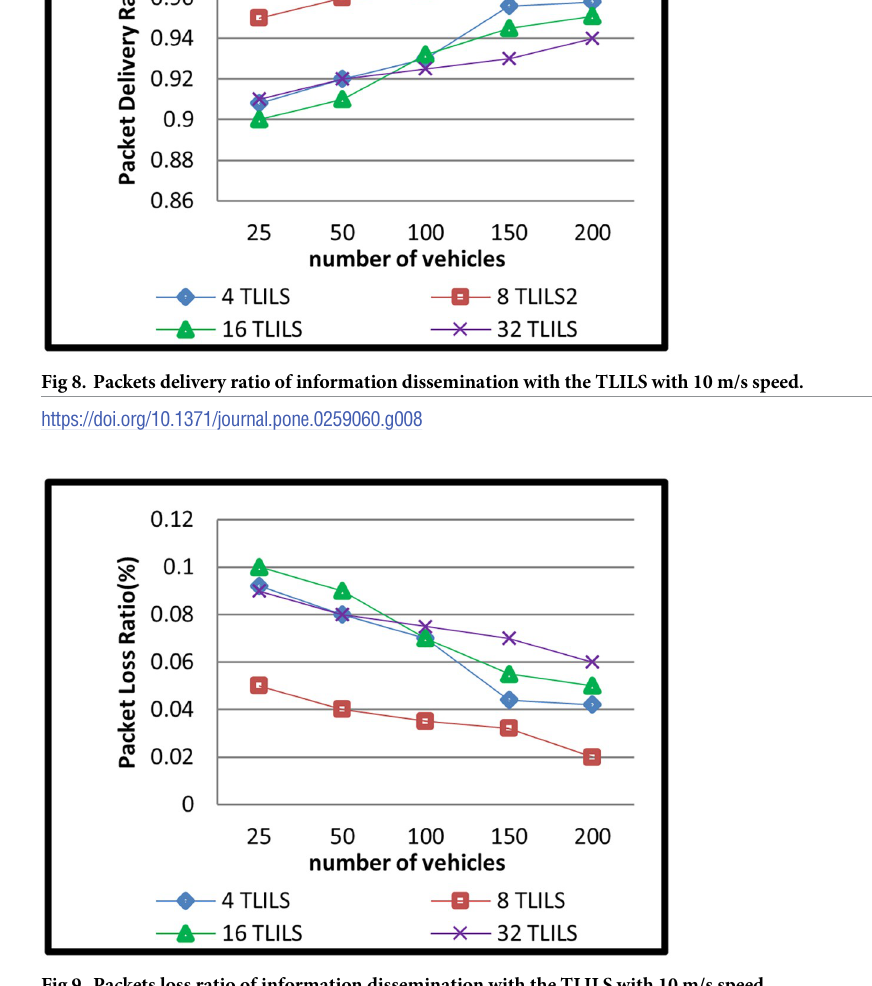
Fig 9. Packets loss ratio of information dissemination with the TLILS with 10 m/s